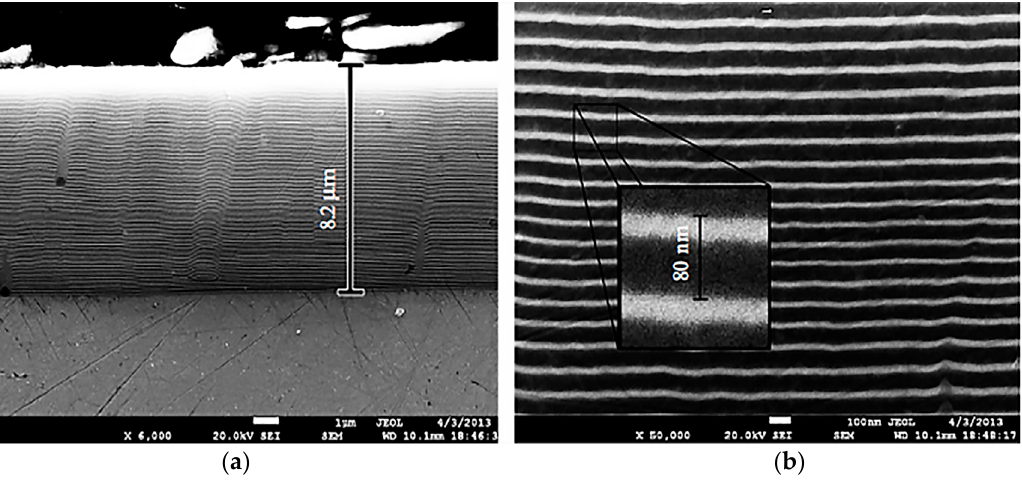
Figure 11. Cross sectional SEM images of the TiN/MoN coatings: ( a ) general view and ( b ) 50000× magnification. Reprinted with permission from [127] 2015 Springer.